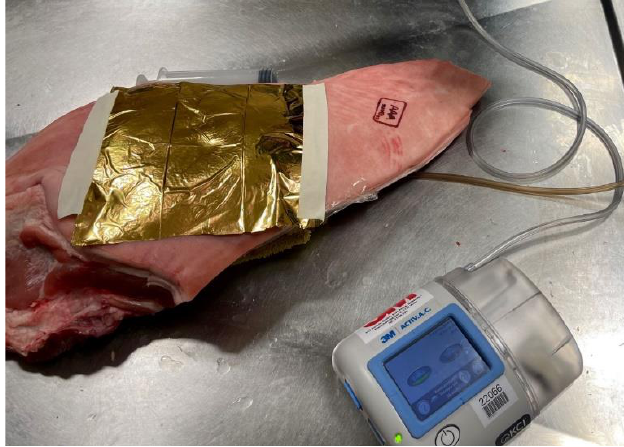
Figure 8. Application of a rescue blanket as a makeshift chest seal.